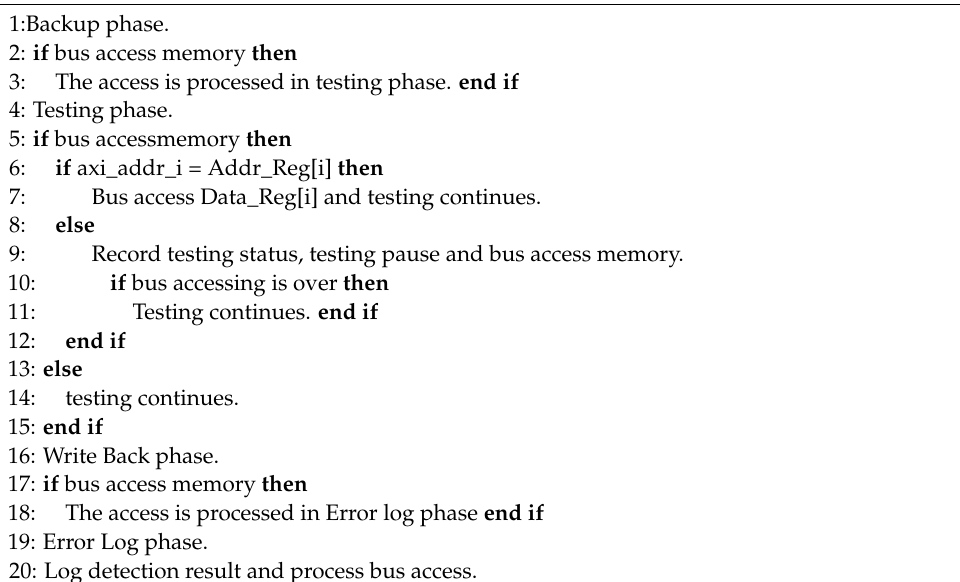
Algorithm 1. Processing of Access Collision.